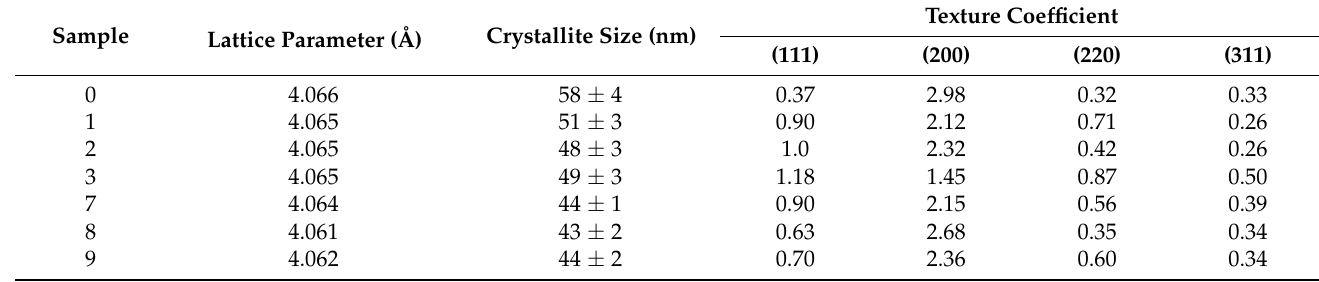
Table 1. Lattice parameter, crystallite size, and texture coefficient of samples 0# to 3# and 7# to 9#.